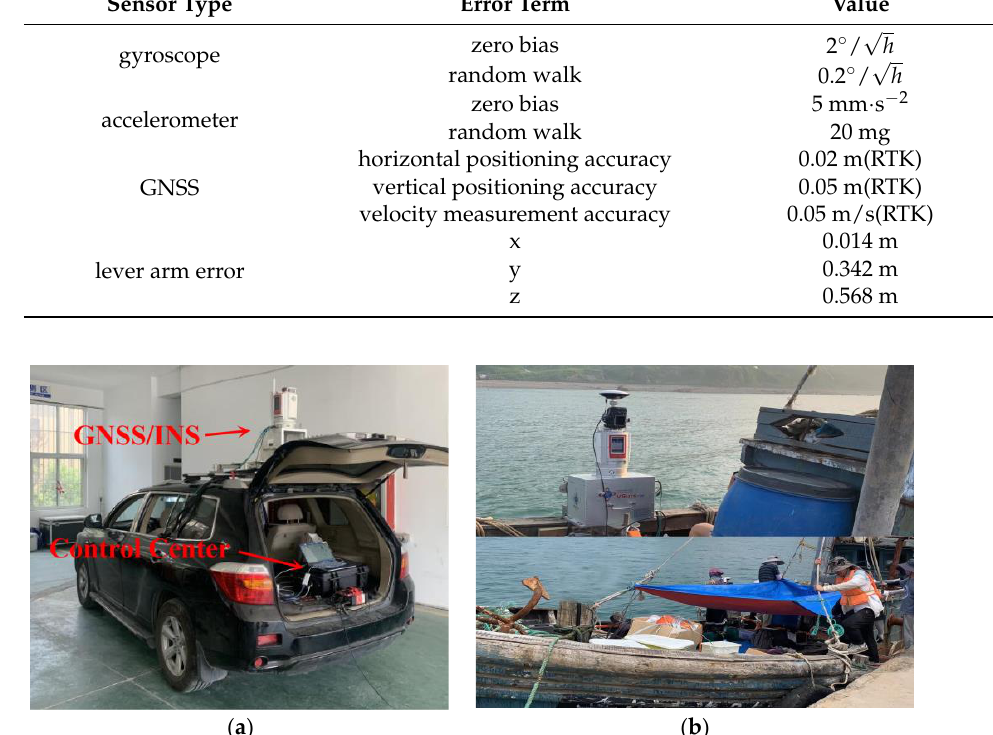
Figure 9. Experimental instrument and carriers: ( a ) vehicle; ( b ) boat. Table 2. Navigation and positioning sensor parameters.